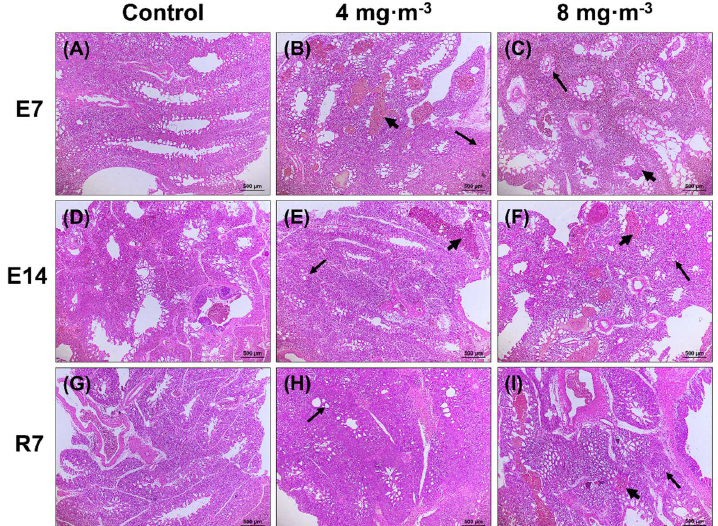
Figure 1. Effects of particulate matter exposure on lung histomorphology of broilers. Hematoxylin and eosin (H&E) staining of the lung. ( A , D , G ) represent the control group after E7, E14, and R7, respectively; ( B , E , H ) represent the exposure group at PM concentration of 4 mg·m −3 after E7, E14, and R7, respectively; ( C , F , I ) represent the exposure group at PM concentration of 8 mg·m −3 after E7, E14, and R7, respectively. The stubby arrows show hemorrhaging in the lungs and bronchi filled with blood cells. The elongated arrows indicate pulmonary capillary shrinkage collapse and deformation. E7, exposure for 7 days; E14, exposure for 14 days; R7, recovery for 7 days.